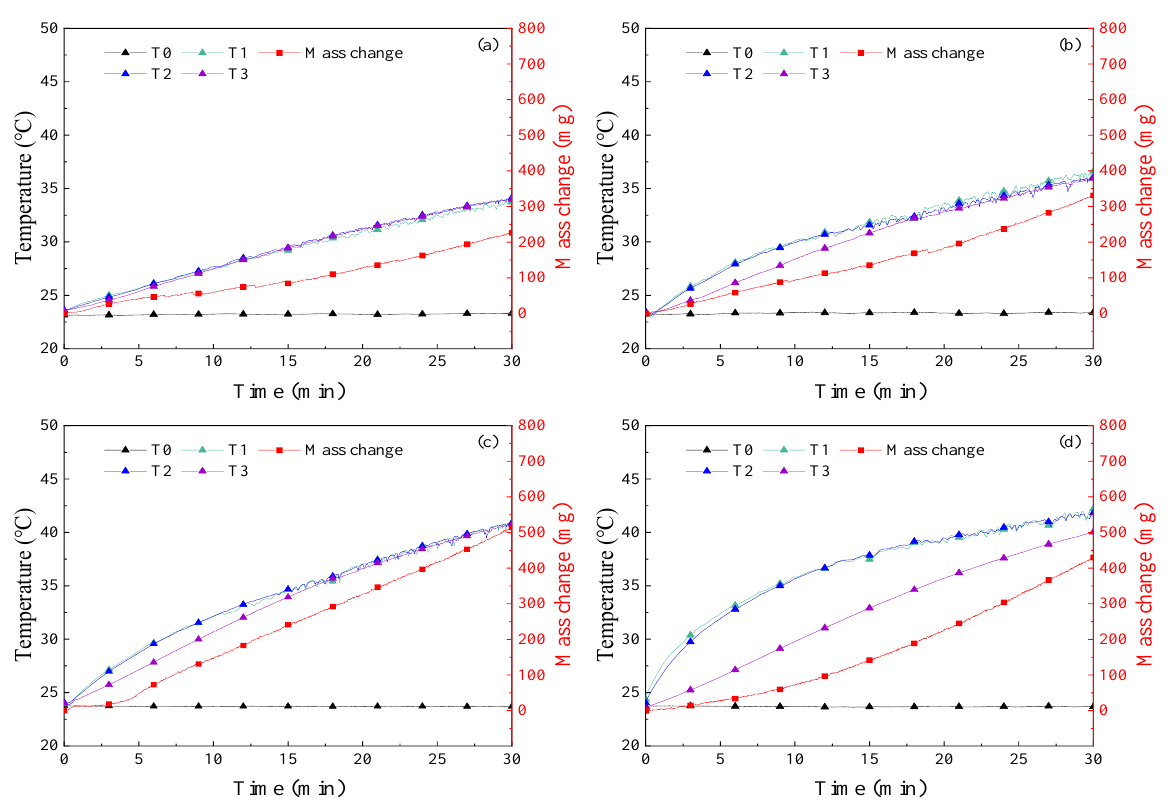
Figure 8. Curves of temperature and mass change of MWCNT nanofluids in experiments on solar – thermal conversion characteristics ( a ) 50 ppm; ( b ) 200 ppm; ( c ) 500 ppm; ( d ) 1000 ppm.